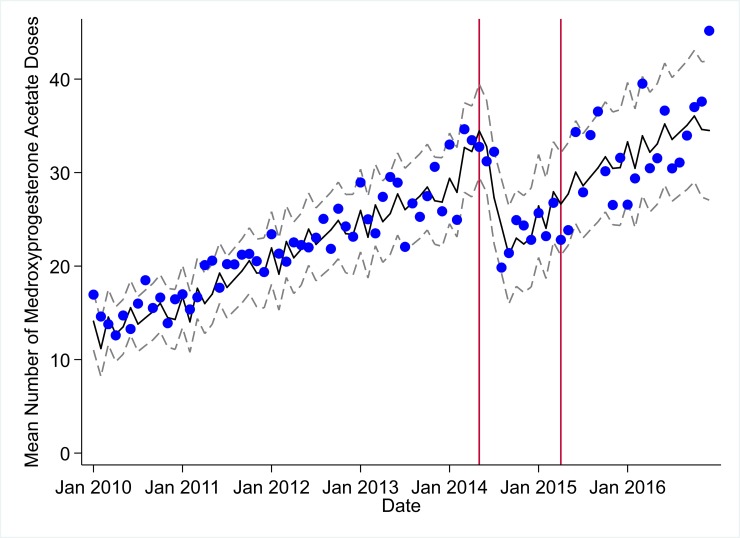
Mean trends and system losses due to Ebola virus disease (EVD) outbreak (June 2014–April 2015) for medroxyprogesterone acetate doses in a census of 379 clinics providing services in Liberia from 2010–2016, excluding Montserrado County.The black solid line represents the fitted mean from a linear mixed model using a segmented regression parameterization, random intercepts and slopes by facility, monthly indicator variables to adjust for seasonality, a fixed effect to adjust for clinic-level catchment area, and an AR(1) structure to account for autocorrelation in residual errors. Gray dashed lines are 95% confidence intervals around the fitted mean. Red lines are placed at the final month before the start (May 2014) and end (April 2015) of the EVD outbreak in Liberia.